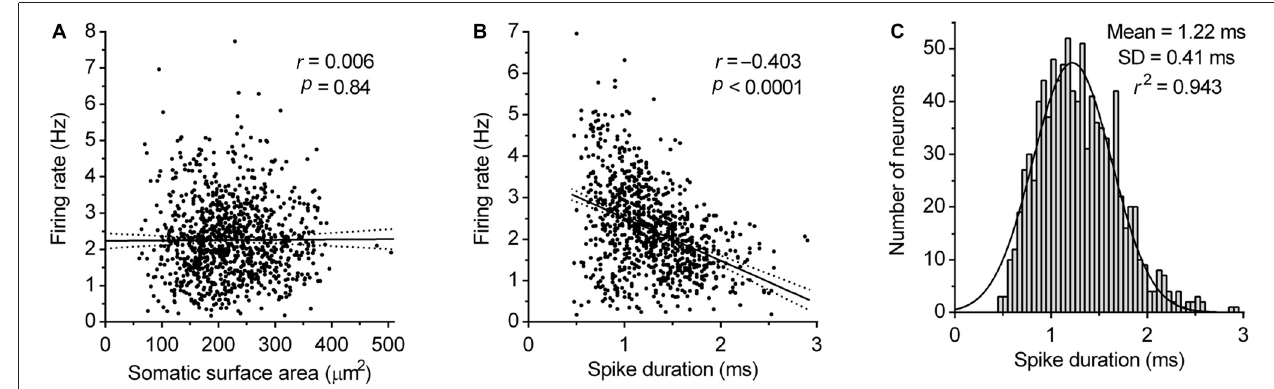
FIGURE 6 | Correlation of firing rate with neuron size and spike duration. (A) Correlation between the firing rate and somatic surface area. Symbols represent individual neurons. Lines represent linear regression and 95% CI. r denotes Pearson’s correlation coefficient. (B) Correlation between the firing rate and spike duration. Symbols represent individual neurons. Lines represent linear regression and 95% CI. r denotes Pearson’s correlation coefficient. (C) Spike duration histogram of DRN serotonergic neuron population. Curve represents best fit by single Gaussian